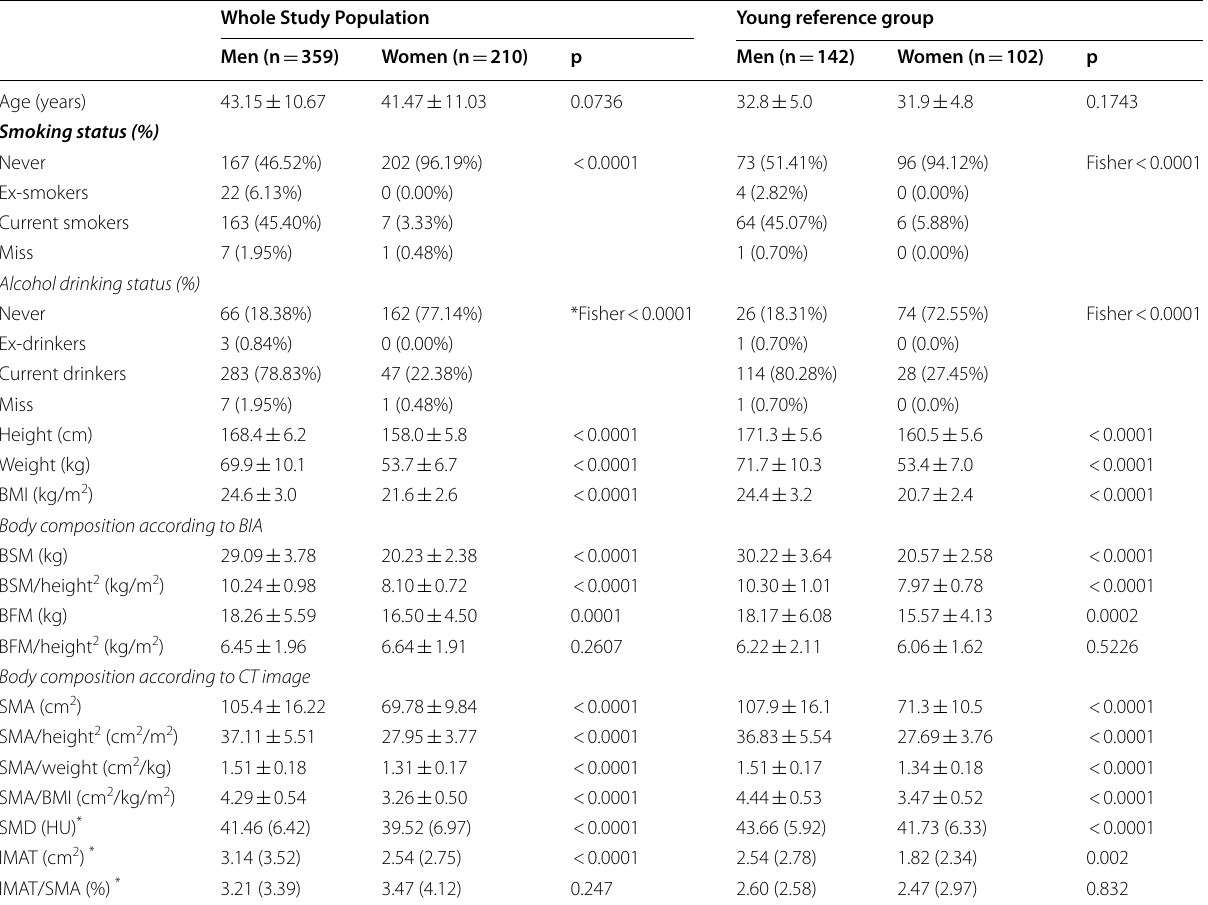
Table 1 Baseline characteristics of the study population and the young adults